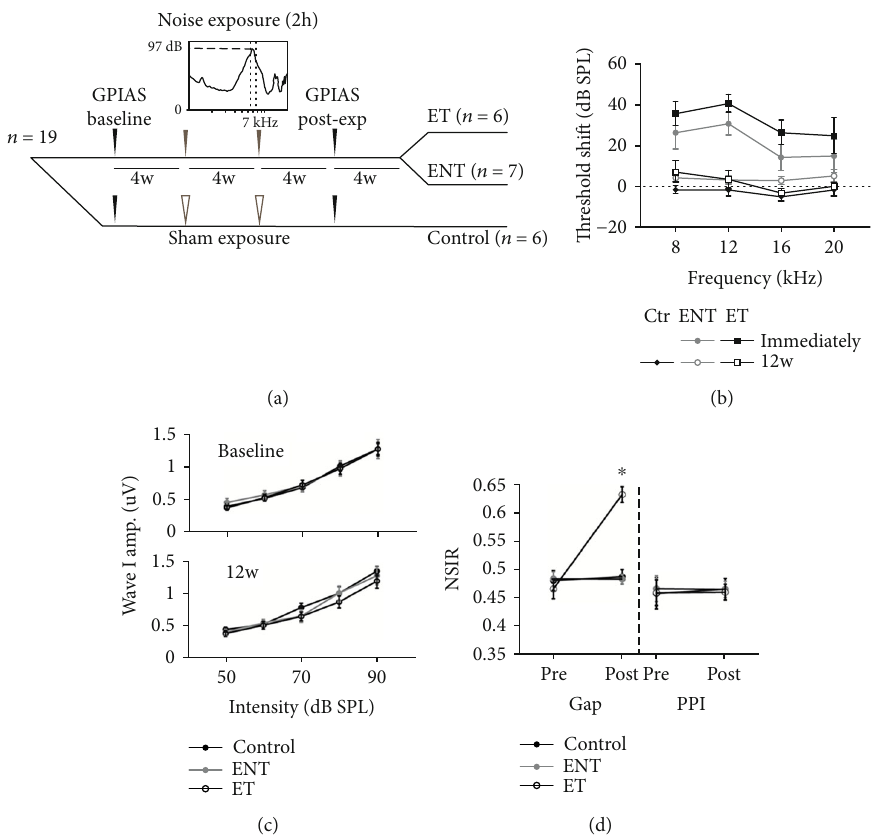
Figure 2: Repeated noise exposure induces tinnitus in a subset of animals. (a) Timeline of the experimental procedures of the chronically exposed group. Nineteen animals were grouped into sham controls ( n = 6 ) and noise-exposed animals ( n = 13 ). GPIAS was used for tinnitus assessment, and the baseline of GPIAS was acquired for four weeks before noise exposure. Animals were noise-exposed to the same noise band/sham for two hours twice in sessions conducted four weeks apart, and then assessed for tinnitus with GPIAS eight weeks following the fi rst noise exposure. ABR measurements were performed before and after each noise exposure and GPIAS. Noise-exposed animals were divided into two further groups according to GPIAS assessment results: noise exposed animals that exhibit no behavioral evidence signs of tinnitus (ENT, n = 7 ) and exposed animals that exhibit behavioral evidence of tinnitus (ET, n = 6 ). (b) Mean ( ± SEM) ABR thresholds of animals with tinnitus (ET) and without tinnitus (ENT). ABR thresholds on the ipsilateral side were